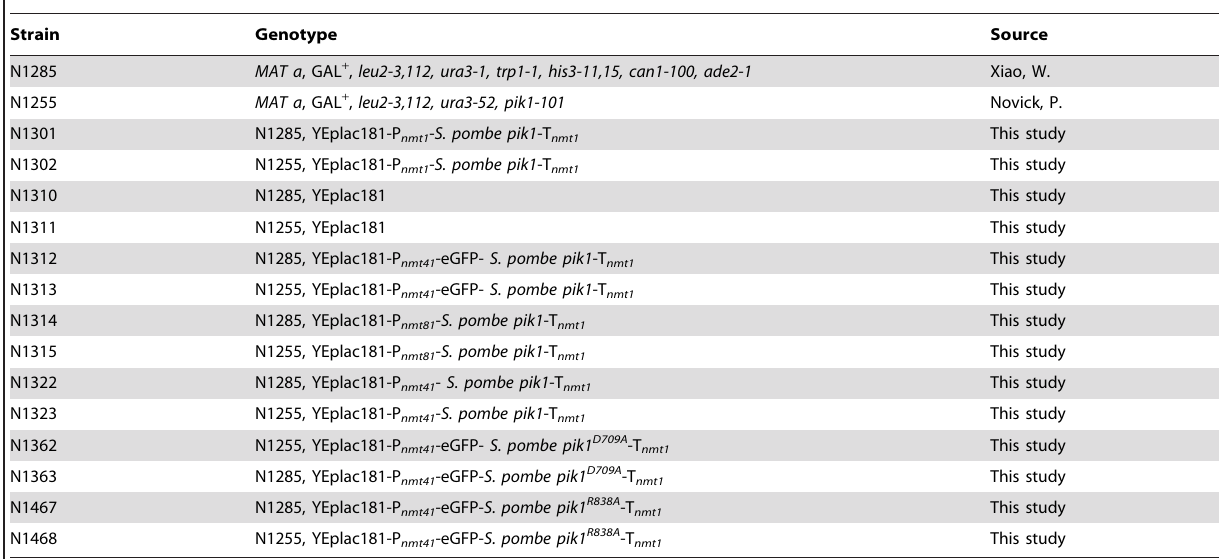
Table 2. Saccharomyces cerevisiae